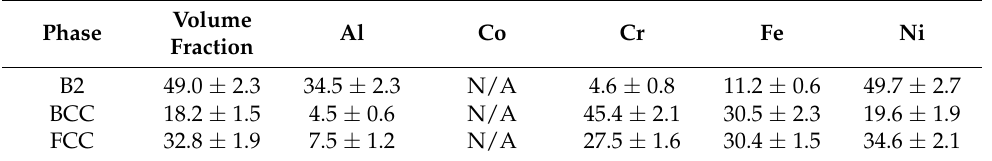
Table 6. Chemical composition (at.%) and volume fraction (%) of the interior phases marked in Figure